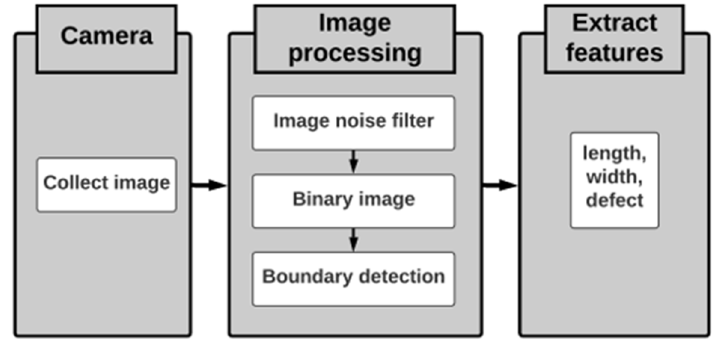
Figure 5. The framework of Image Processing.